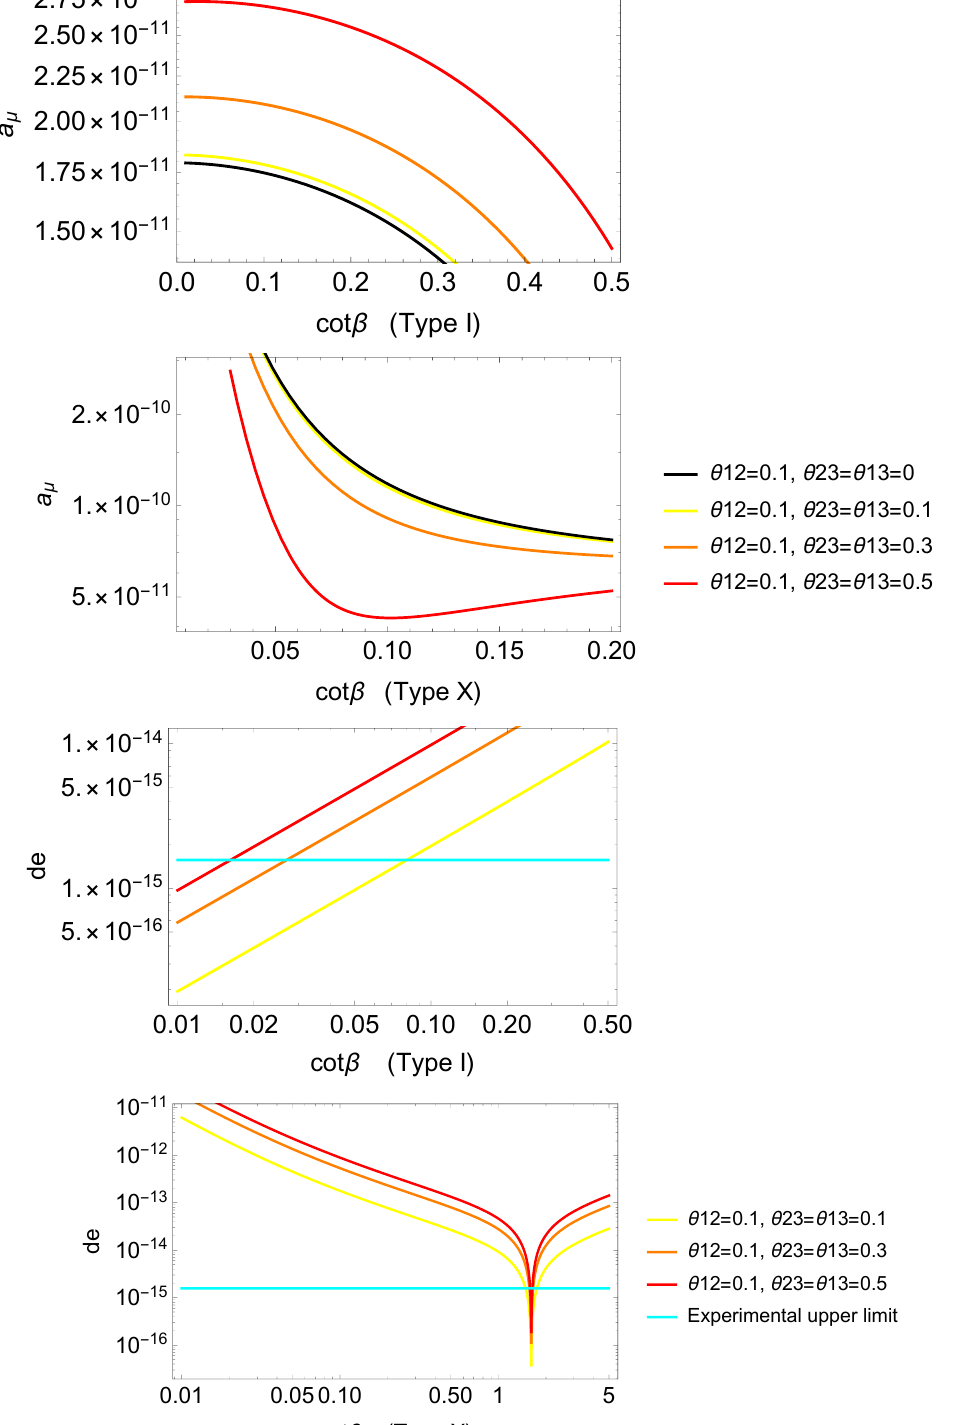
Figure 14 . a (cid:22) (top) and d e (bottom) values in Type I (top) and Type X (bottom) for di(cid:11)erent values of angles and (cid:12)xed values of masses ( m h = 200 ; 50 GeV). The behaviour of Type Y and II 2 ; 3 are similar to Type I and X,